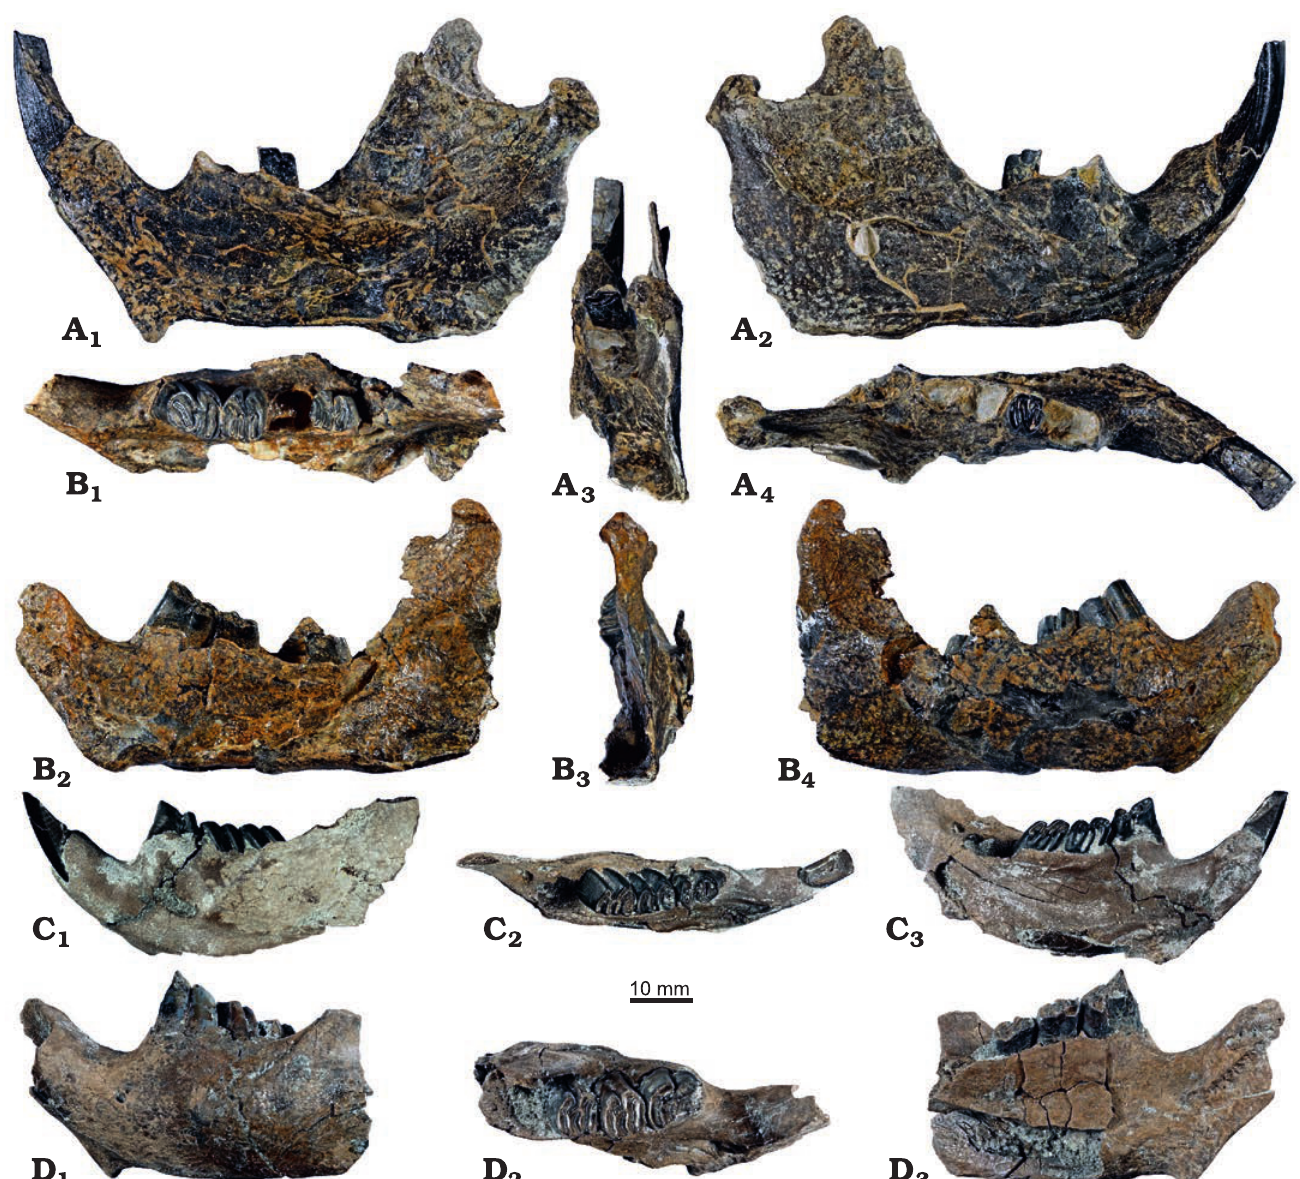
Fig. 6. Mandibles of the beaver Steneofiber depereti Mayet, 1908, from the early Late Miocene locality Hammerschmiede (Bavaria, Germany), local stratigraphic levels HAM 5 and HAM 4. A . GPIT/MA/13813, HAM 5, right mandible with angular process, part of the coronoid process, i2 and m1 in lingual (A 1 ), buccal (A 2 ), distal (A 3 ) and occlusal (A 4 ) views. B . GPIT/MA/09909, HAM 5, right mandible with angular process, p4, m1 and m3 in oc- clusal (B 1 ), lingual (B 2 ), distal (B 3 ) and buccal (B 4 ) views. C . GPIT/MA/17569, HAM 4, left mandible with i2, dp4, m1 and m2 (juvenile) in buccal (C 1 ), occlusal (C 2 ) and lingual (C 3 ) views. D . GPIT/MA/17068, HAM 4, left mandible with i2 (fragment), p4 (fragment), m1 and m2 in buccal (D 1 ), occlusal (D 2 ) and lingual (D 3 )